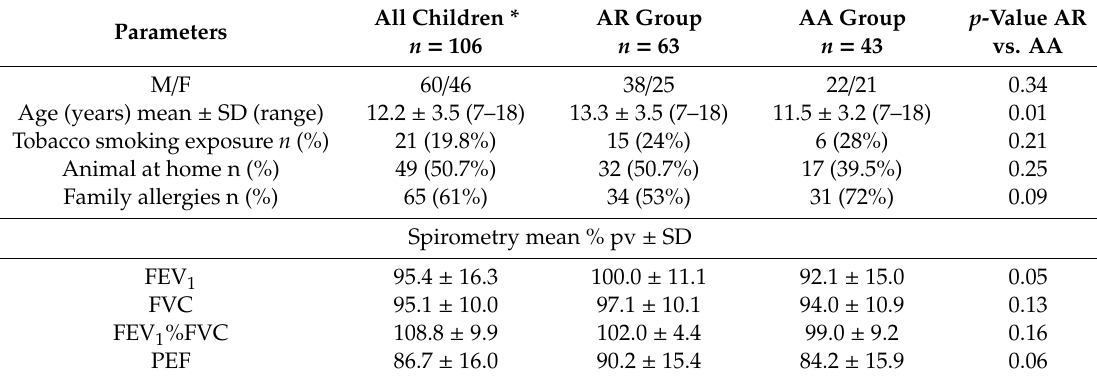
Table 1. Clinical and lung function characteristics of patients.